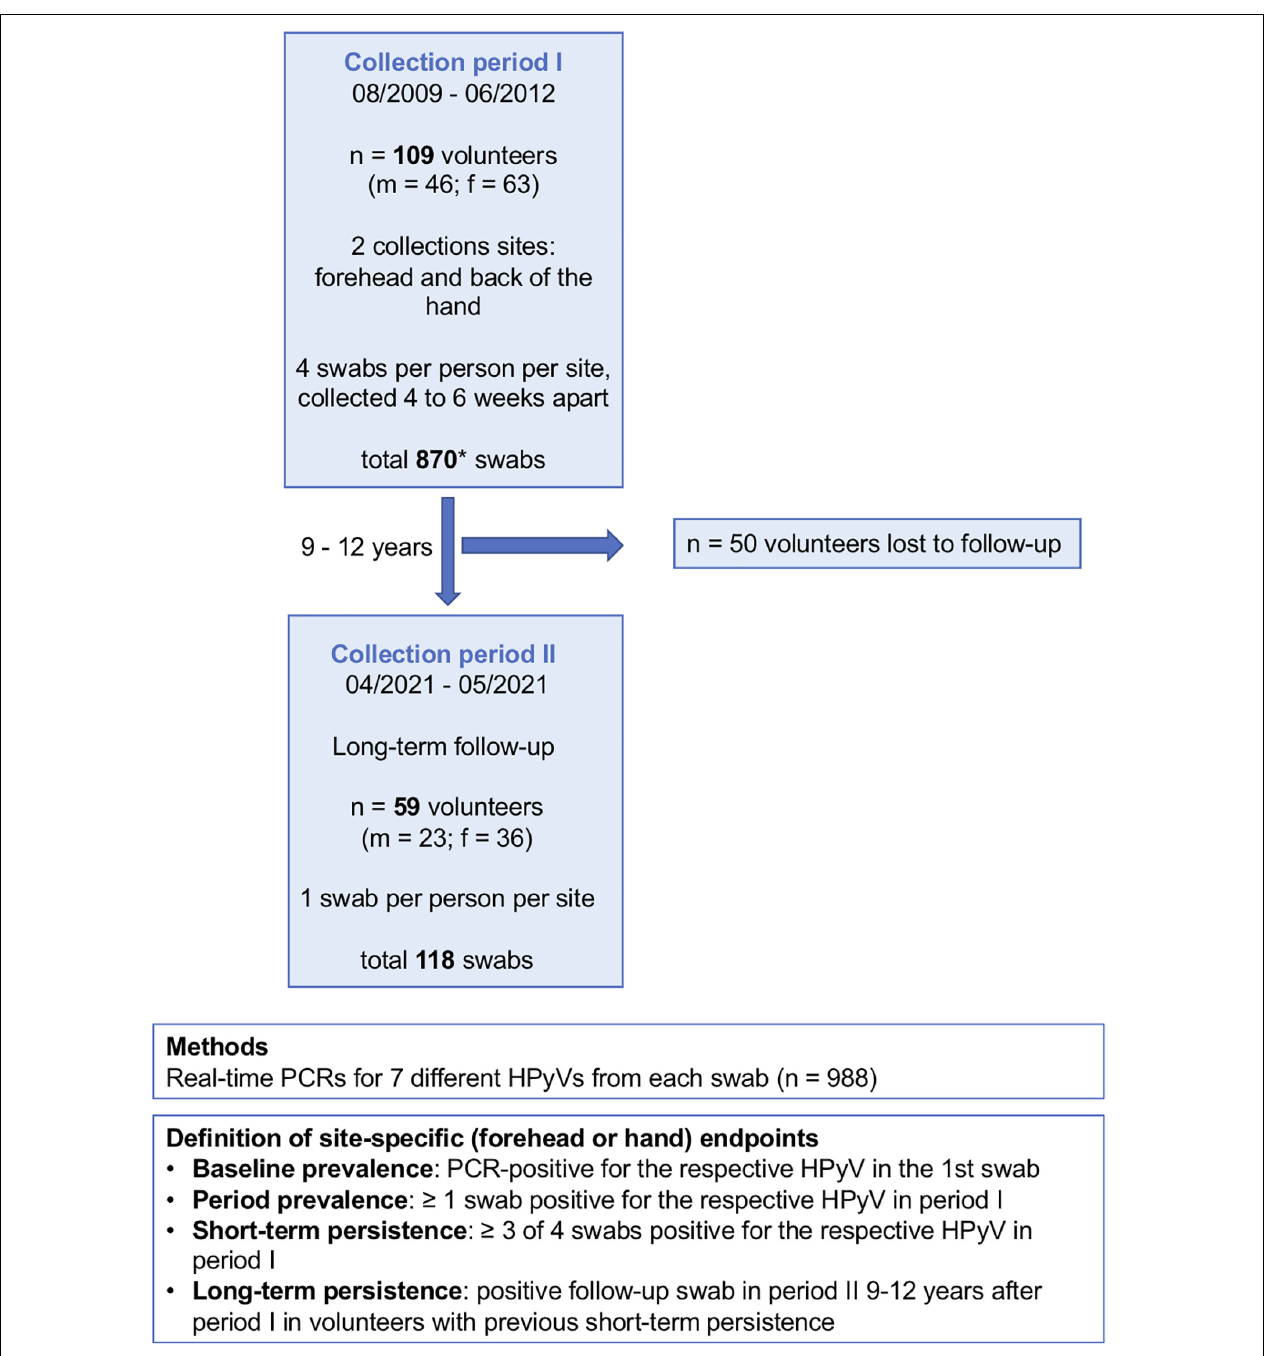
FIGURE 1 | Study design. f, female; m, male; n, number; HPyV, human polyomavirus.